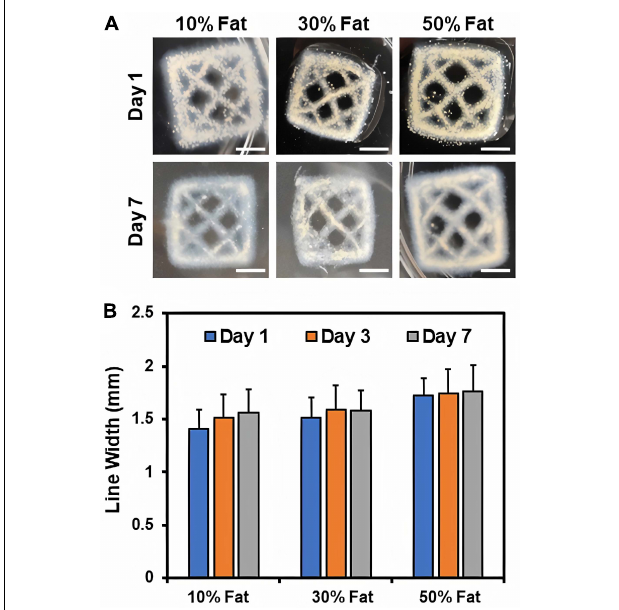
FIGURE 3 | (A) High quality images of 3D printed microfat-laden collagen constructs with different concentrations of microfat over time. Scale bar: 5 mm. (B) Line width measurement of the inner mesh for assessment of print fidelity and stability of microfat-laden 3D printed collagen